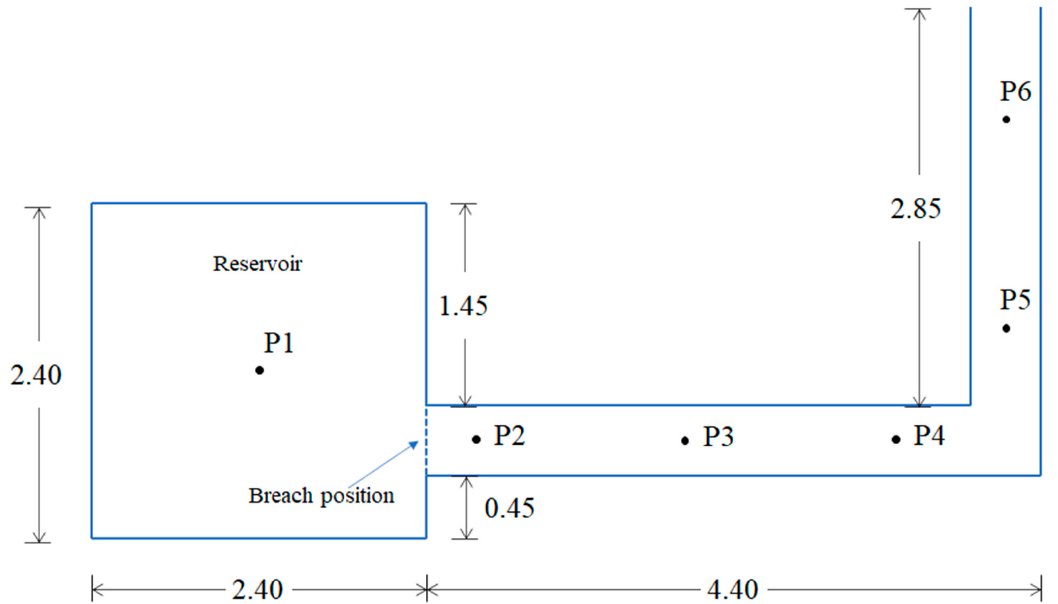
Figure 5. Dam-break fl ow in a 90° curved channel: schematic diagram in the 90° curved channel. The contour plot of the depth at t = 1 s, 3 s, 5 s, and 10 s is displayed in Figure 6 a–d, respectively. The contour plot results can directly re fl ect the water resistance at the straight corner of the river channel. In this case, the dam breaks at the beginning of the simulation, and an overland fl ow model simulates the water fl ow processes within 40s.